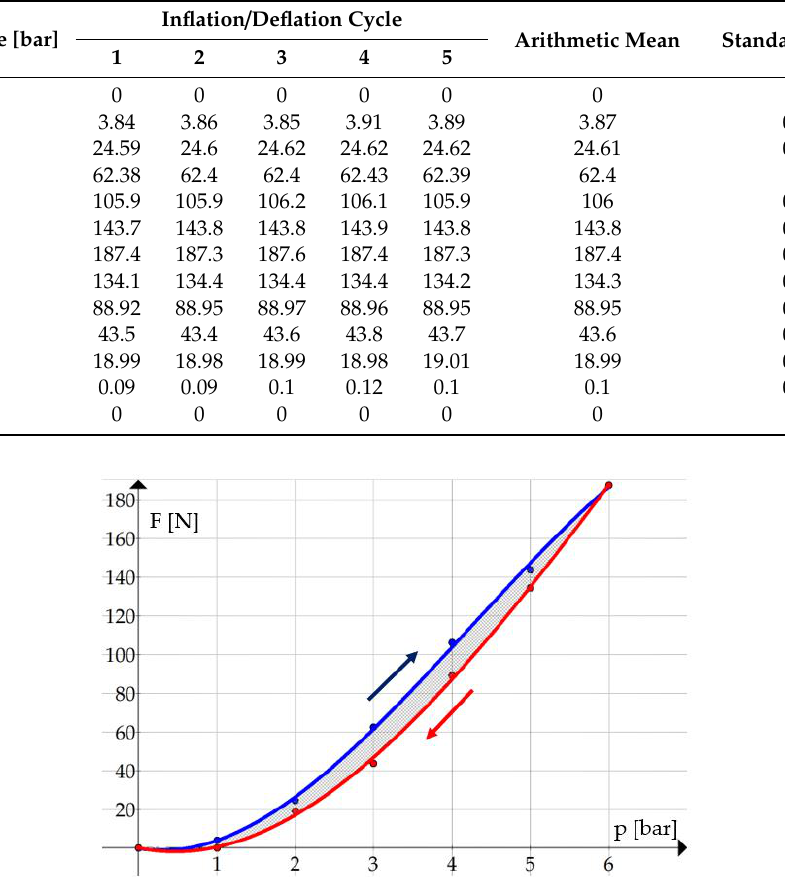
Table 4. Correspondence between the developed force and the charging pressure.